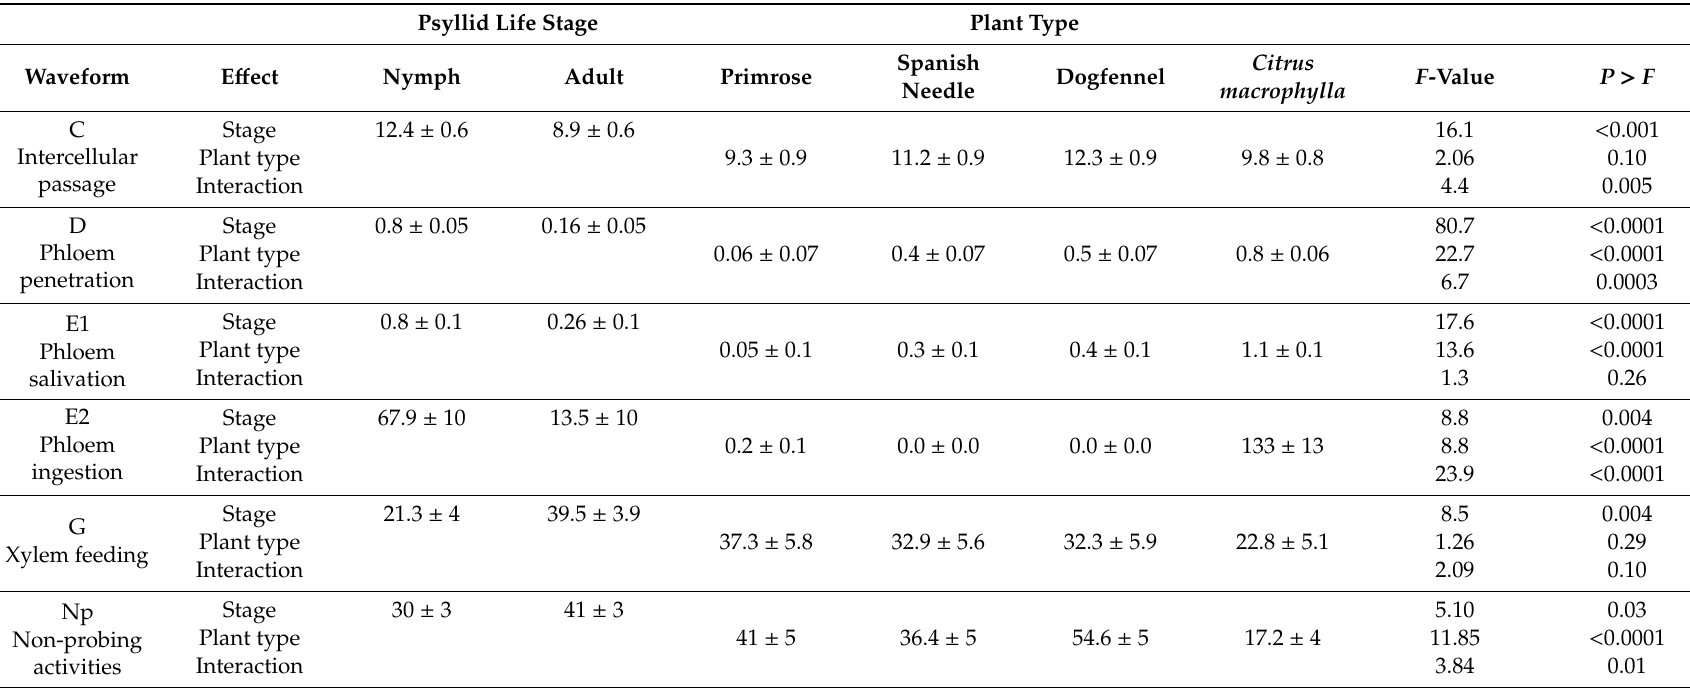
Table 2. Mean ( ± SEM) duration (min) of individual feeding activity bouts by Diaphorina citri adults and nymphs on weed species and C . macrophylla during 18 h